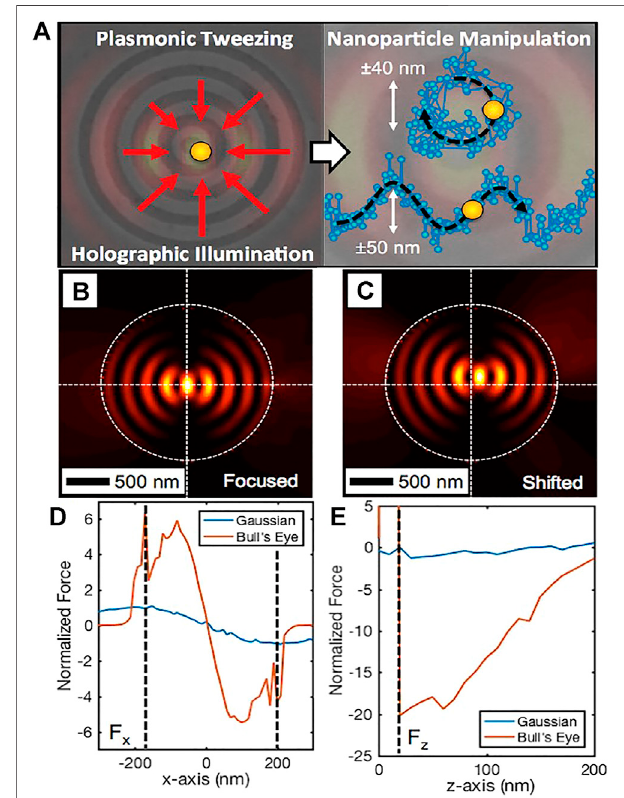
FIGURE 3 | (A) the plasmonic bull ’ s eye with the direction of the plasmonic waves used to trap the particle in the centre and some trajectories that can be generated with time-dependent beams; (B) centred hot spot simulated with equation ( Eq. 9 ); (C) shifted phase pro fi le hot spot simulated with equation ( Eq. 9 ); (D) Normalized Force plot for a Bull ’ s Eye device and a conventional optical tweezers for x-component Force.; (E) Normalized Force plot for a Bull ’ s Eye device and a conventional optical tweezers for z-component force. (Complete with permission from Huft et al. (2017). Copyright 2017 American Chemical